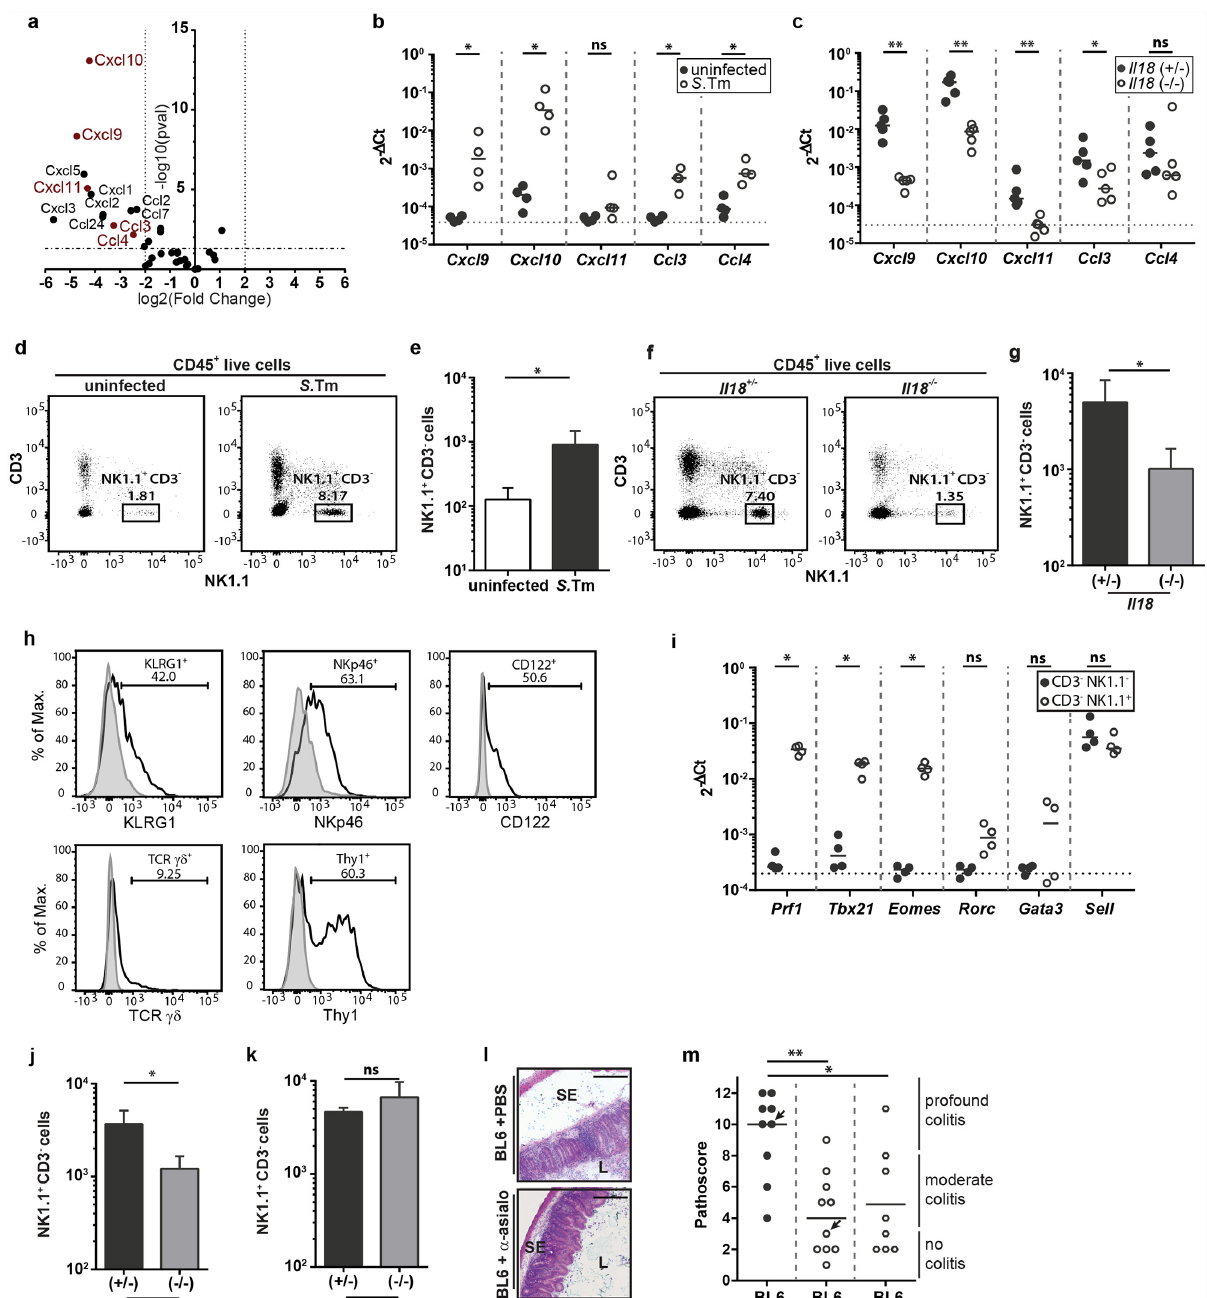
Fig 3. IL-18 enhances the recruitment of NK cells into the infected cecum LP thereby stimulating early cecal inflammation. (a) Il18 -/- mice and littermate controls were Sm-pretreated, infected orally with 5x10 7 CFU S .Tm for 12h (n = 3 – 4 per group). RNA-Seq was performed on RNA extracted from complete cecum tissue. RNA-Seq analysis: The Volcano plot shows the induction (log 2 fold change) versus the -log 10 p-value for all chemokines. Chemokines able to induce NK cell recruitment are highlighted in red. (b) C57BL/6 WT mice were Sm-pretreated and either uninfected or infected orally with 5x10 7 CFU S .Tm for 12h (n = 4 per group). Cxcl9 , Cxcl10 , Cxcl11 , Ccl3 and Ccl4 mRNA levels in whole cecum tissue were measured by RT-qPCR. Results are presented relative to the expression of Actb . (c) Same as (b) but comparing cecum tissues from infected Il18 -/- mice vs infected littermate controls. (d and e) Flow cytometric analysis of isolated cecal LP cells from Sm-pretreated C57BL/6 WT mice, either uninfected or infected with 5x10 7 CFU S .Tm (n = 5 per group). Single live cells were gated on CD45 + lymphocytes. (d) Representative dot plots and (e) quantification of NK1.1 + CD3 - cells. (f and g) Flow cytometric analysis of isolated cecal LP cells from Il18 -/- mice and littermates, Sm-pretreated and orally infected with 5x10 7 CFU S .Tm for 12h (n = 5 – 6 per group). Single live cells were gated on CD45 + lymphocytes. (f) Representative dot plots and (g) quantification of NK1.1 + CD3 - cells. (h)